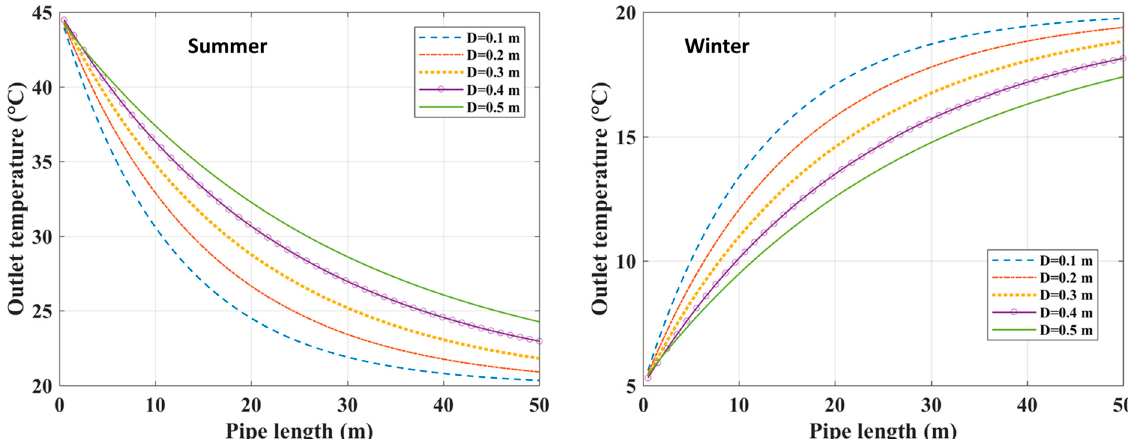
Figure 13. The outlet temperatures of the EAHE system as a function of different pipe lengths and diameters.